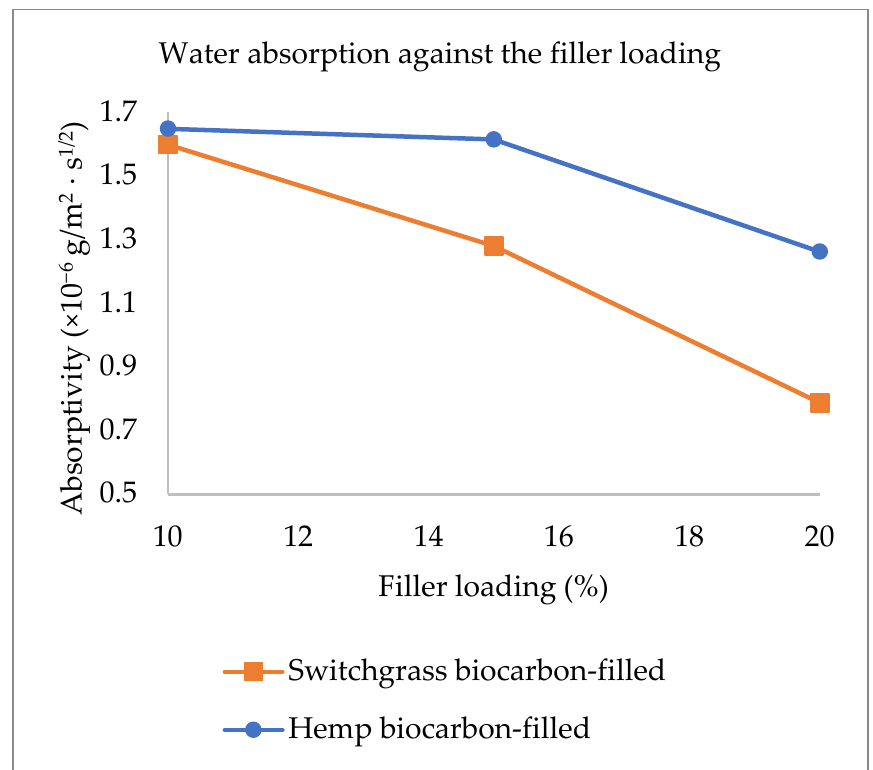
Figure 14. Main effect of the filler loading on the water absorptivity.